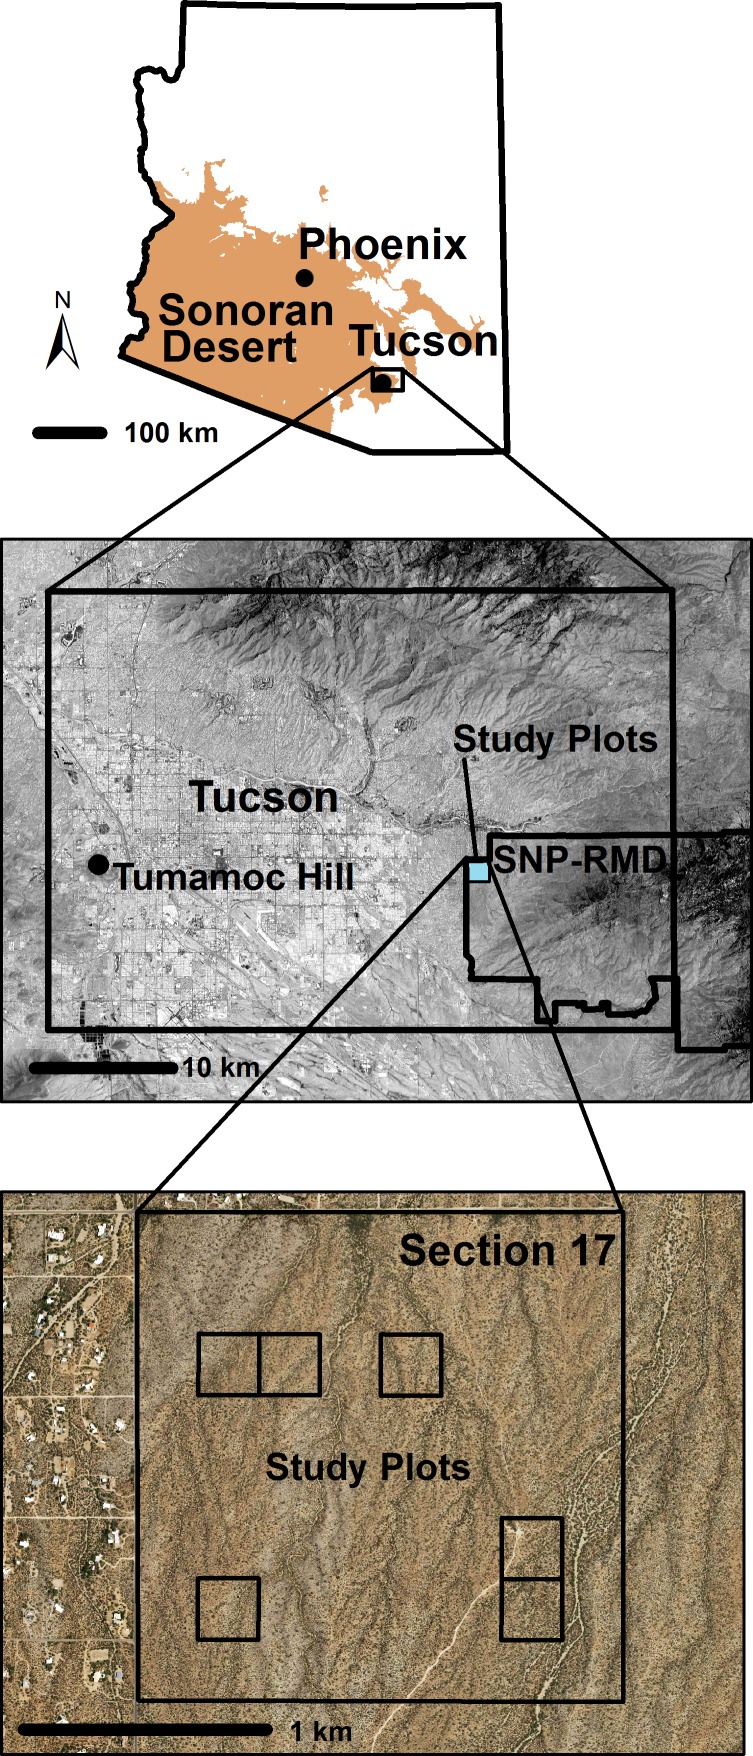
Location of study plots in the Rincon Mountain District of the Saguaro National Park (SNP-RMD) east of Tucson, AZ.Census plots are located in Section 17, Township 14S, Range 16E, Gila and Salt River Base and Meridian. The base map for the middle panel is a June 1, 2015 Landsat 8 image and the base map for the bottom panel is May 30, 2015 NAIP JPG2000 aerial image, both from the United States Geological Survey EROS data center. The illustration of the Sonoran Desert in the upper panel is derived from the Natural Vegetation layer available in the public domain section of the AZGEO Clearinghouse.